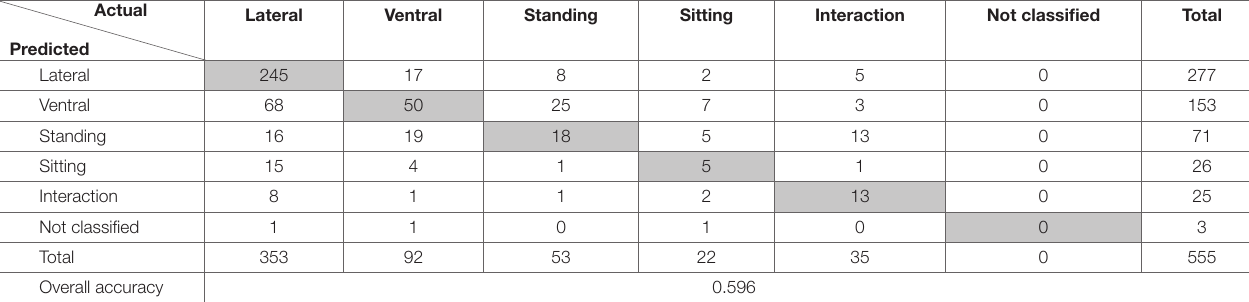
TABLE 5 | Confusion matrix of the body posture/behavior classifications identified by the hierarchical conditional statement.